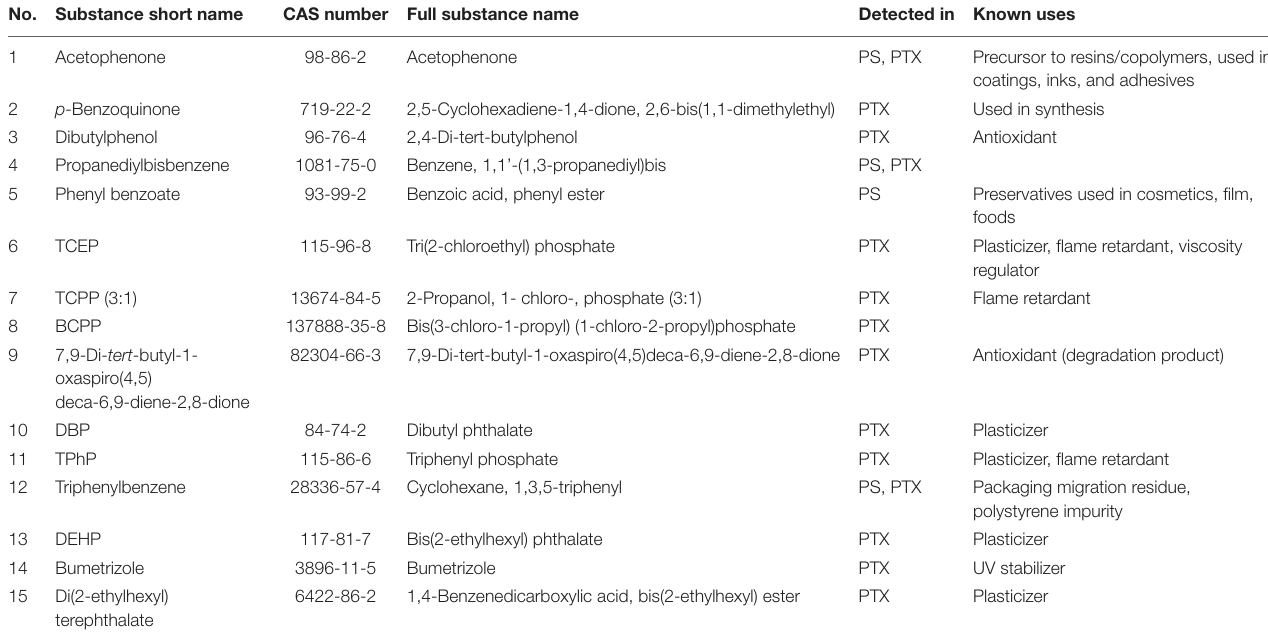
TABLE 1 | Compounds monitored by GC-MS SIM